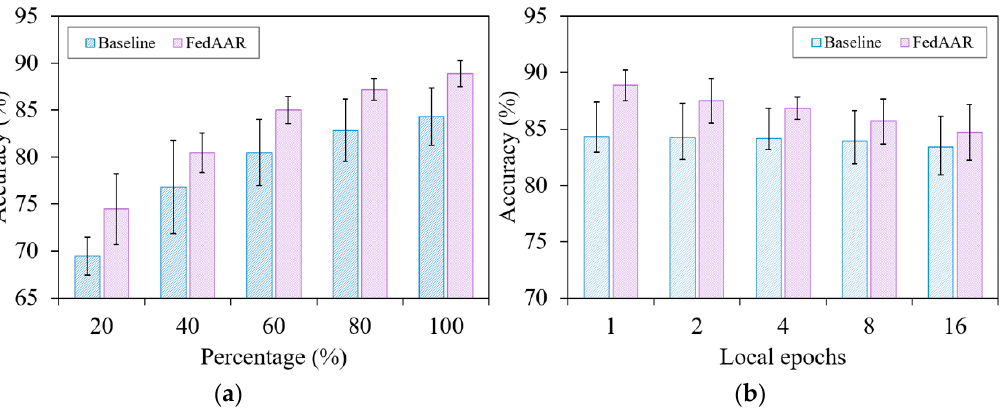
Figure 5. Testing accuracy of FedAAR and its baseline over varying ( a ) local dataset sizes and ( b ) local updating epochs.